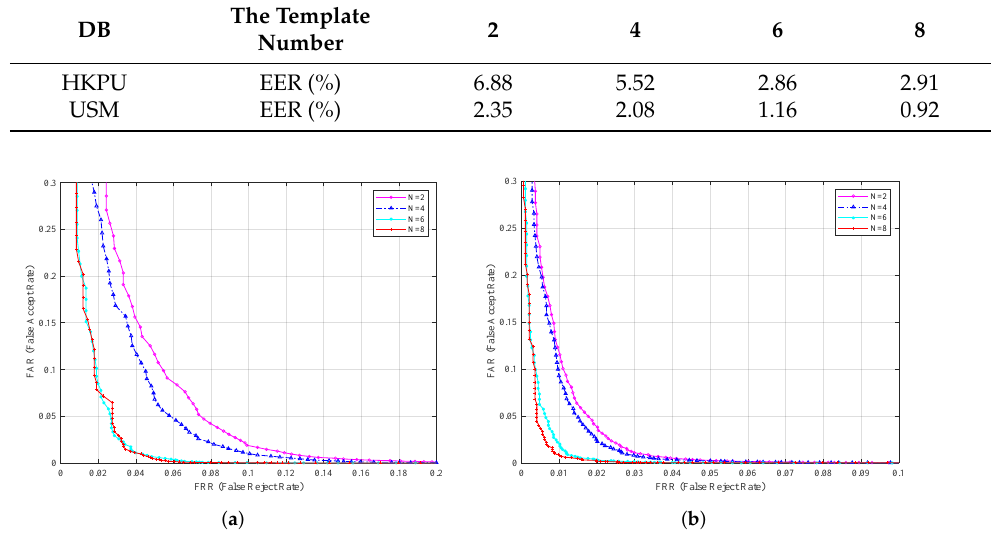
Figure 4. ROC curves with different templates on two databases: ( a ) on HKPU database; ( b ) on USM database.